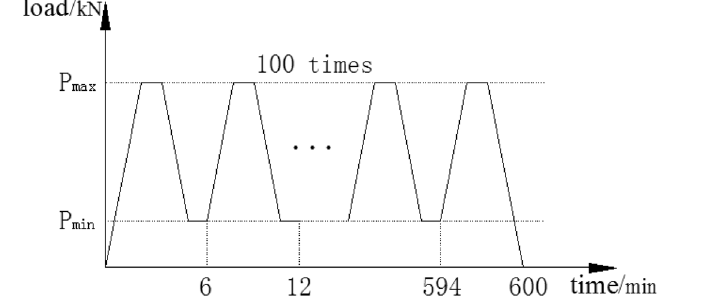
Figure 3. Overloading